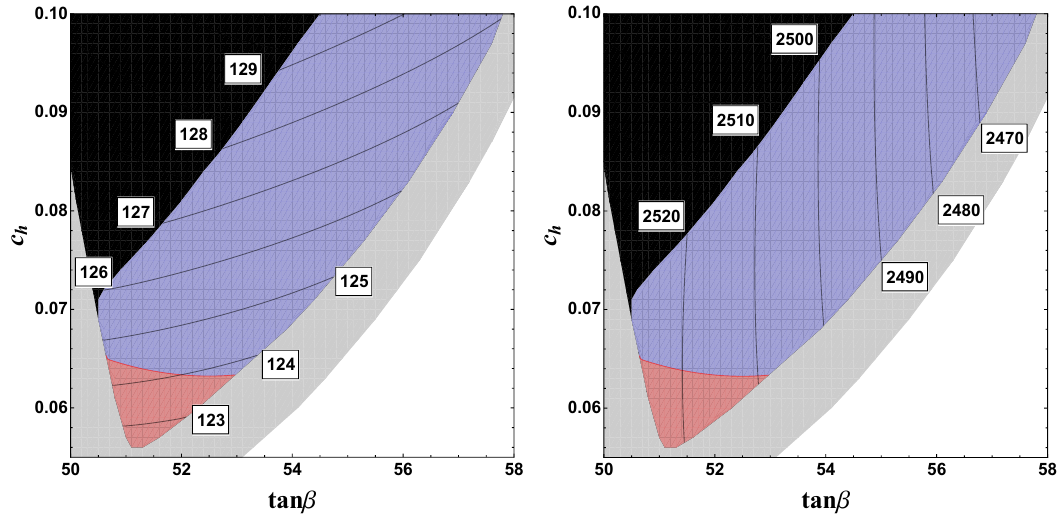
Figure 2 . The 1 (cid:27) [red] and 2 (cid:27) [blue] regions of the muon g (cid:0) 2. The contours of the Higgs boson mass [GeV] and the left-handed squark mass [GeV] in (cid:12)rst two generations are also shown in the left and right panels respectively. Black region may be excluded due to the vacuum decay. On the gray region the LSP is not the wino-like neutralino. We take m = 146 TeV ; M inp = 3 (cid:2) 10 12 3 = 2